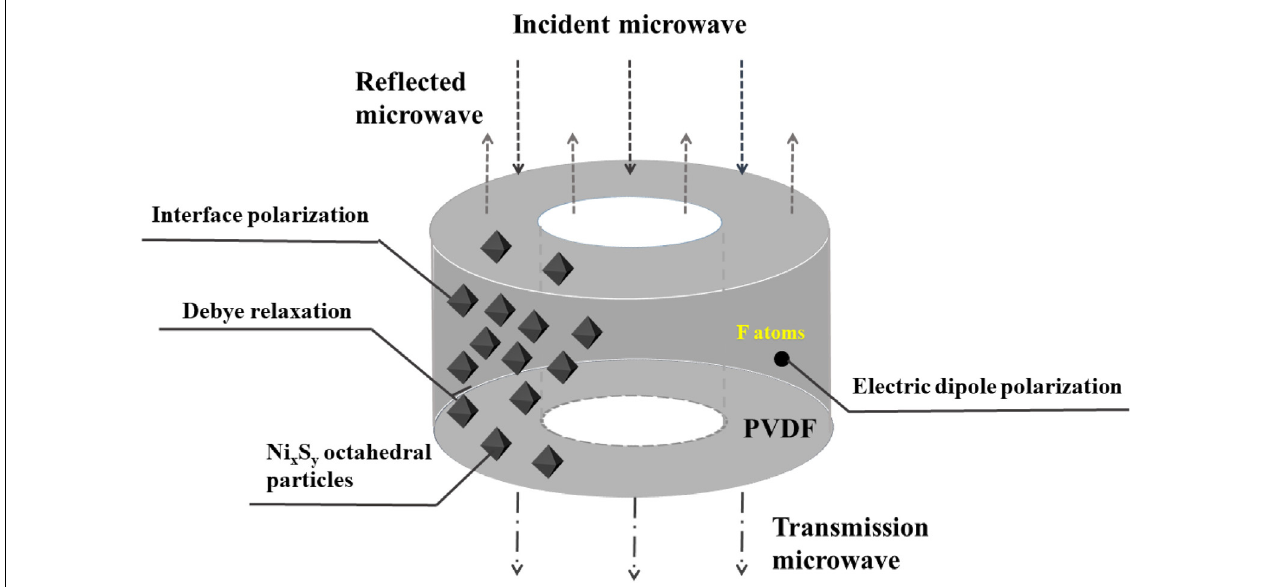
FIGURE 6 | Possible mechanisms of microwave absorption for cylindrical Ni x S y /PVDF composites.